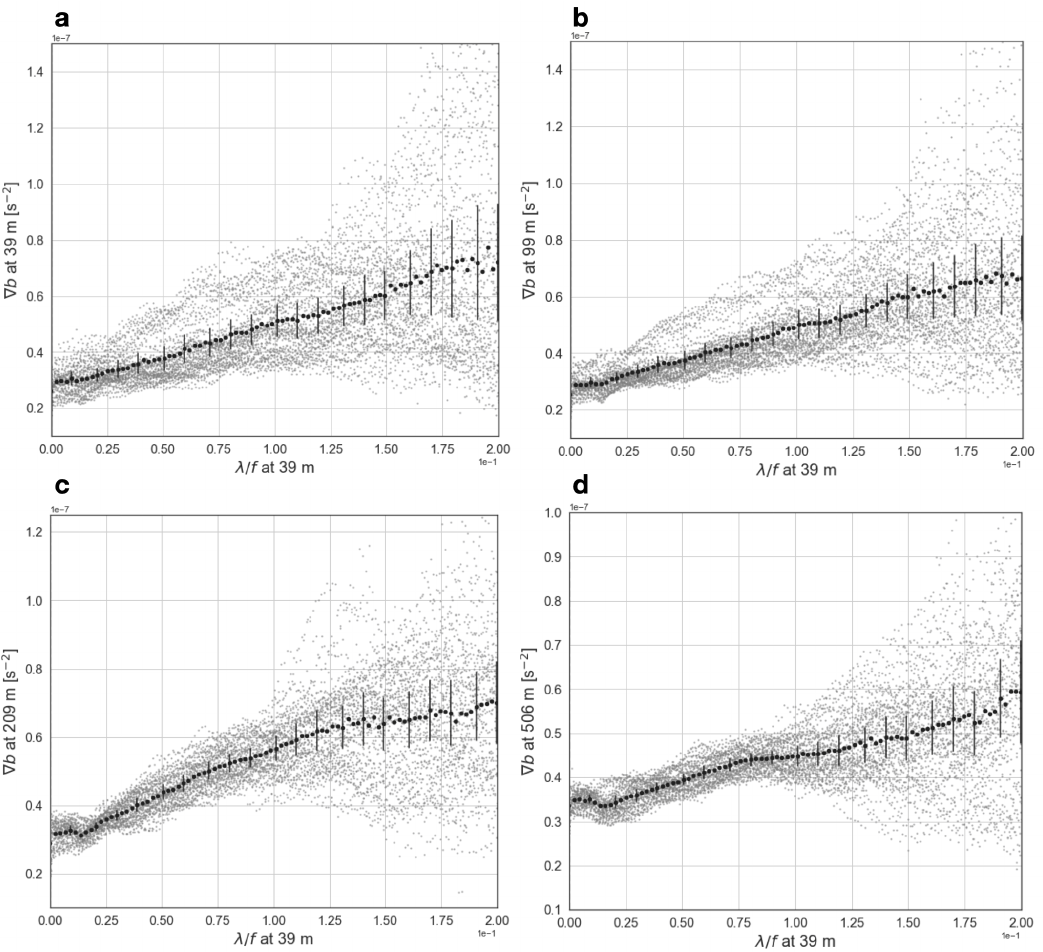
Figure 10. Scatter plots between FSLE filt ( λ ) normalized by f at 39 m and |∇ b | at ( a ) 39m, ( b ) 99 m, ( c ) 209 m, ( d ) 506 m between 27 October and 27 December 2011. Gray points represent the average over each grid interval on the abscissa for a given day (that has a total of 200 grid intervals), black points represents the average over the time period and thin vertical lines show std dev around the